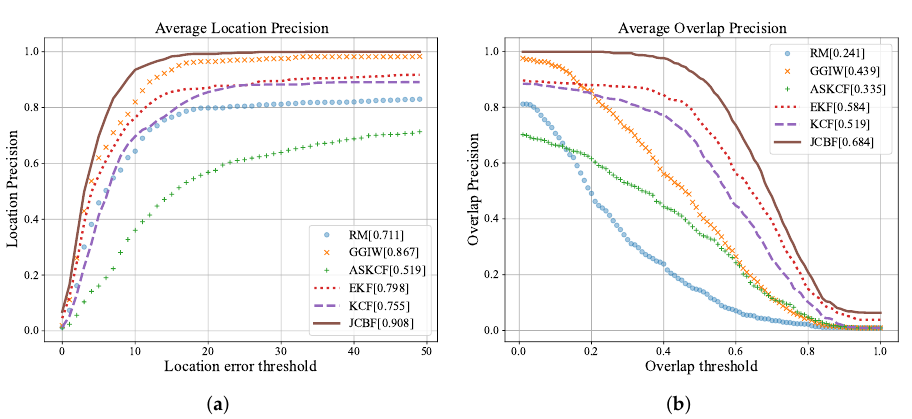
Figure 5. Average location precision and overlap precision of twelve targets. ( a ) Average location precision curves ( DP ∈ [ 0,1 ] ) of twelve targets. ( b ) Average overlap precision curves ( OP ∈ [ 0,1 ] ) of twelve